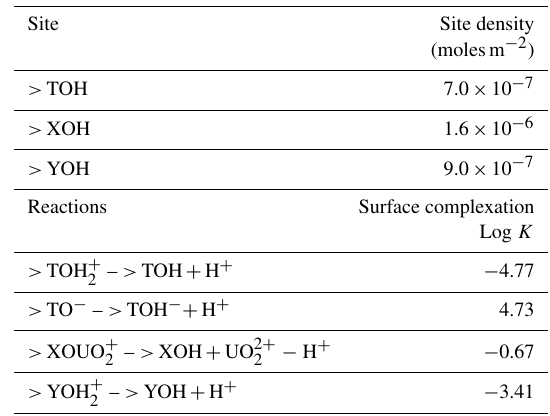
Table 4. NEM model parameters for H + and U(VI) competitive sorption (Arora et al.,